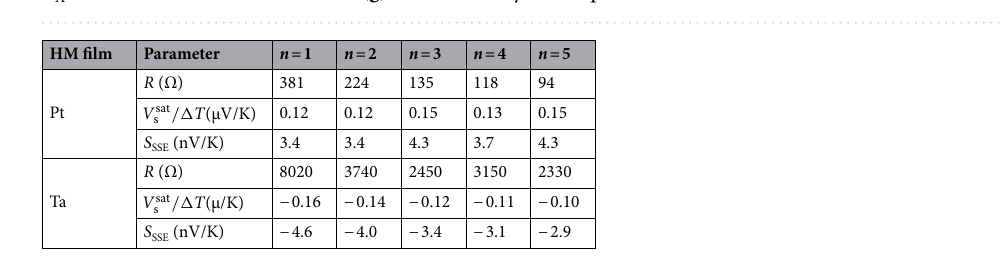
Figure 6. ( a ) Photograph of the [Pt film/Fe 3 O 4 nanoparticle] 1 film on the polyimide sheet annealed at T A = 473 K. The spin Seebeck voltage V S as a function of in-plane magnetic field H x under various temperature difference Δ T for ( b ) [Pt film/Fe 3 O 4 nanoparticle] 1 , ( c ) [Ta film/Fe 3 O 4 nanoparticle] 1 , ( d ) [Ru film/Fe 3 O 4 nanoparticle] 1 ( e ) [Pt film/Fe 3 O 4 nanoparticle] 5 , and ( f ) [Ta film/Fe 3 O 4 nanoparticle] 5 films, where films were sat2 annealed at T A = 473 K. The ideal maximum thermoelectric power V S /4 R as a function of the number of stacking n for ( g ) [Pt film/Fe 3 O 4 nanoparticle] n and ( h ) [Ta film/Fe 3 O 4 nanoparticle] n films with annealing at T A = 473 K. Black broken line in the ( g ) is estimated by least ‐ squares method.